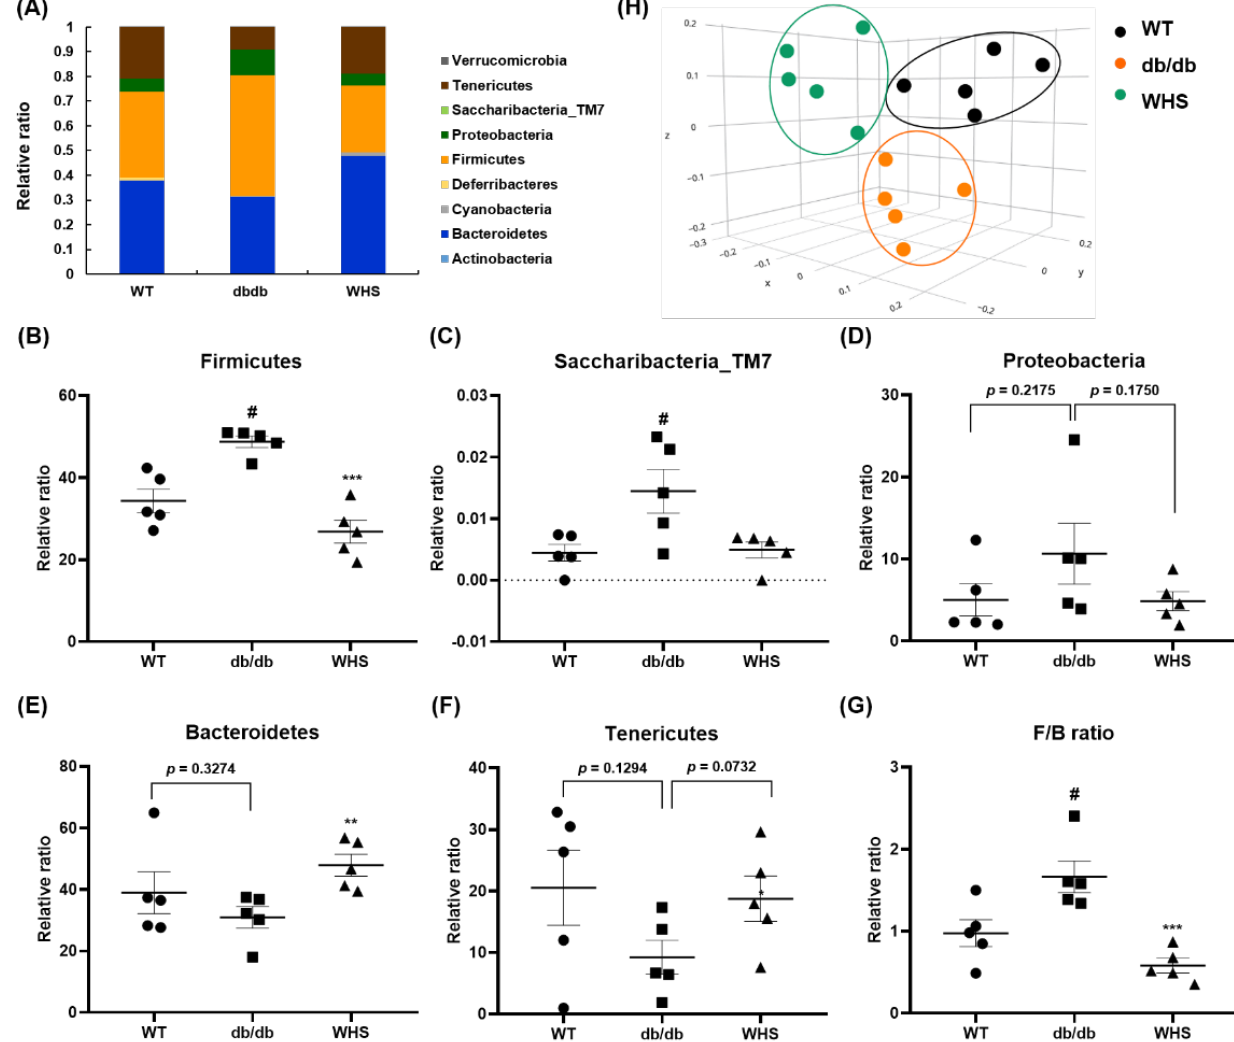
Figure 7. Effect of WHS on gut dysbiosis in db/db mice. ( A ) Gut microbiota composition of each group (phyla). ( B – G ) Relative ratio of the phyla Bacteroidetes , Firmicutes , Saccharibacteria _TM7, Proteobacteria , and Tenericutes . ( H ) β -diversity between groups analyzed by PCoA. Values are expressed as the mean ± SEM. # p < 0.05 vs. WT control group; ** p < 0.01 and *** p < 0.001 vs. db/db control group.